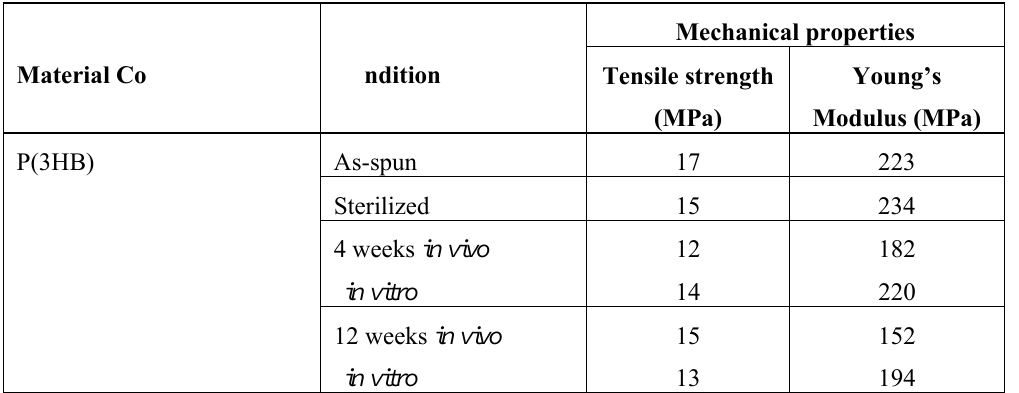
Table 1. Mechanical properties of PHA copolymers before and after in vivo implantation and in vitro degradation